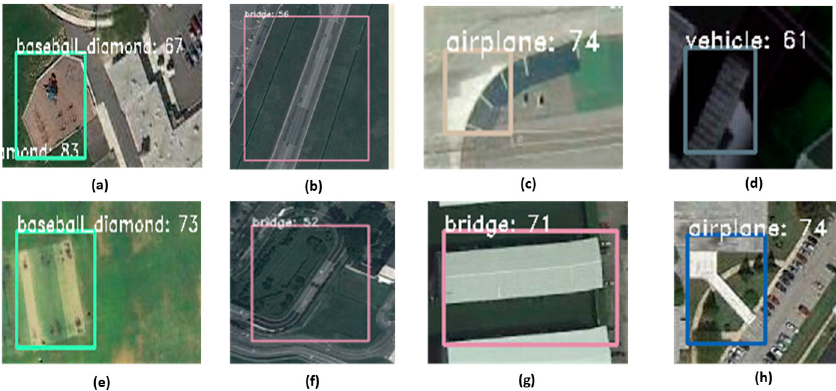
Figure 15. The precision ratio of ablation studies for each class in the NWPU VHR-10 dataset.